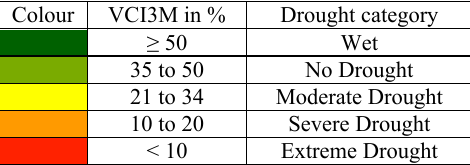
Table 1: Thresholds for monthly updated VCI3M and related drought categories